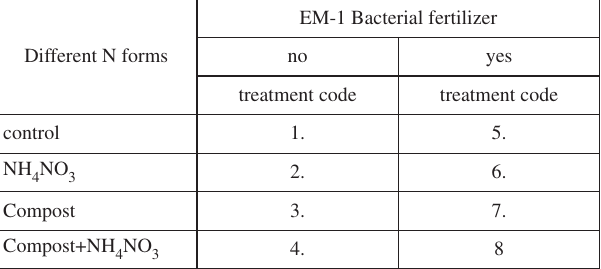
Table 2. Scheme of treatments applied